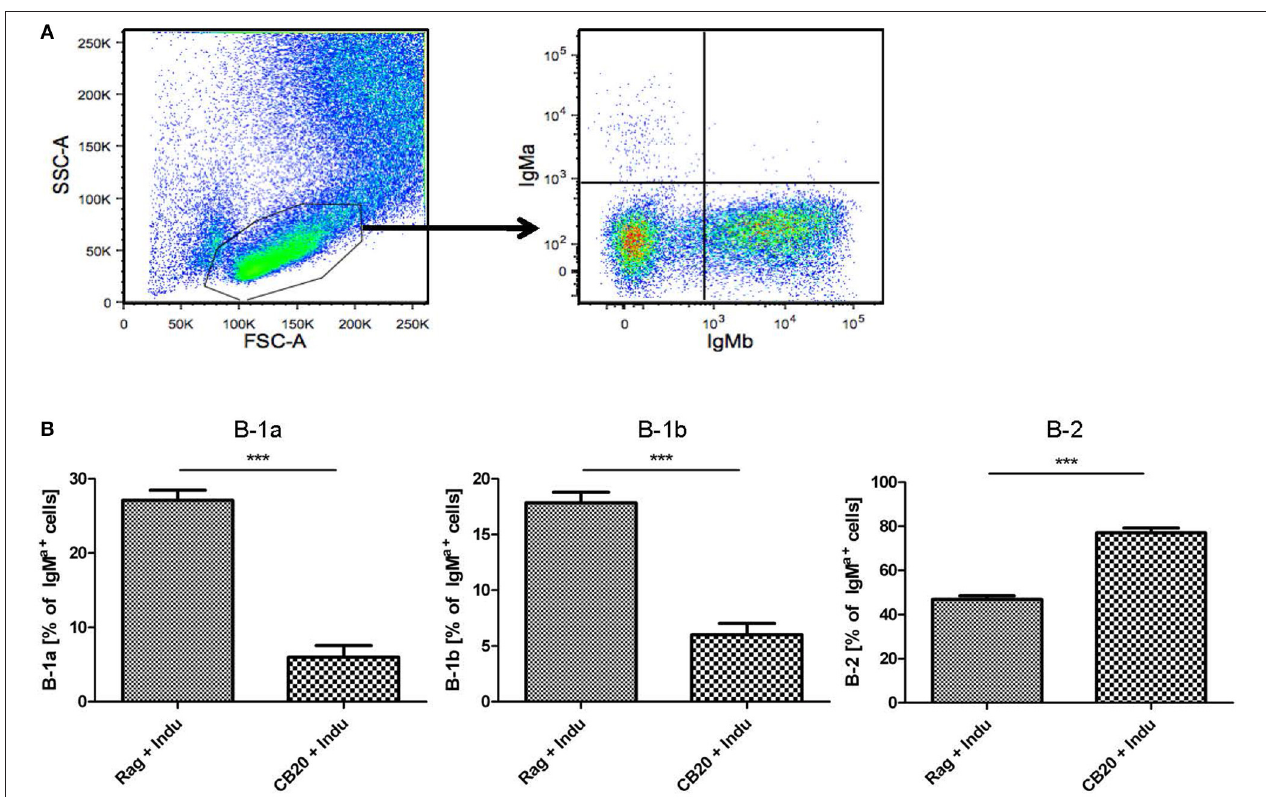
FIGURE 6 | B lymphopoiesis in the adult BM can contribute to the mature B-1a cell pool. Tracking newly generated B-1a cells derived from adult BM. After irradiation conditioning, CB20 mice (IgM b ) or Rag1 − / − mice (no endogenous IgM + cells) were reconstituted with B-Indu-Rag1-derived BM (IgM a ). 6 weeks later, cohorts of chimeric CB20 recipients were administered with TAM to induce B lymphopoiesis from engrafted B-Indu-Rag1 BM. (A) Dot plots depict representative flow cytometry of IgM a and IgM b surface expression among gated viable cells (FSC/SSC) among peritoneal exudate cells from CB20 mice (IgM b ) at day 21 after TAM treatment. (B) Tracking mature IgM a + B cell subsets (B-1a, B-1b, B-2) among peritoneal exudate cells of chimeric Rag1 − / − (left) and CB20 (right) mice. Graphs depict the percentage of B-Indu-Rag1 BM-derived IgM a + cells as median values ± SEM; asterisks in graphs indicate the level of significance, as indicated. ( n = 5 mice